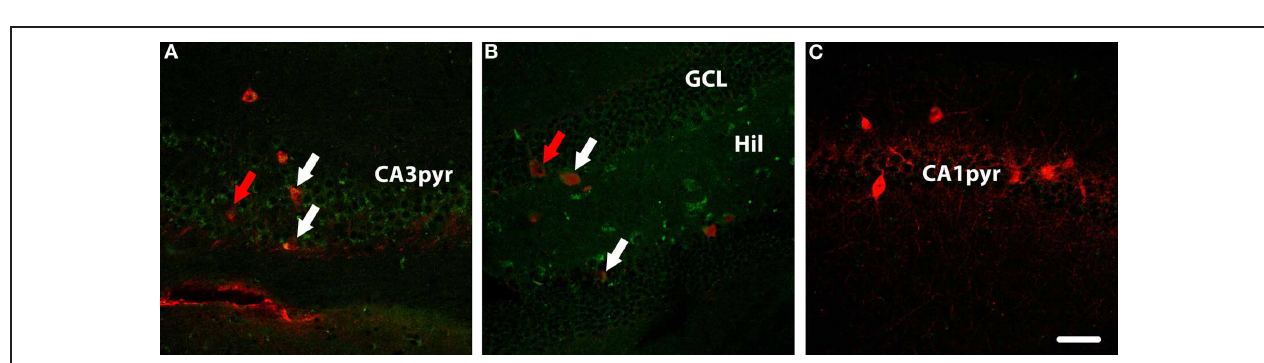
(red arrow) were found. In dentate gyrus (B) the same patterns were seen. (C) In CA1, only parvalbumin + /WGA − interneruons were observed. Scale is 50 μ